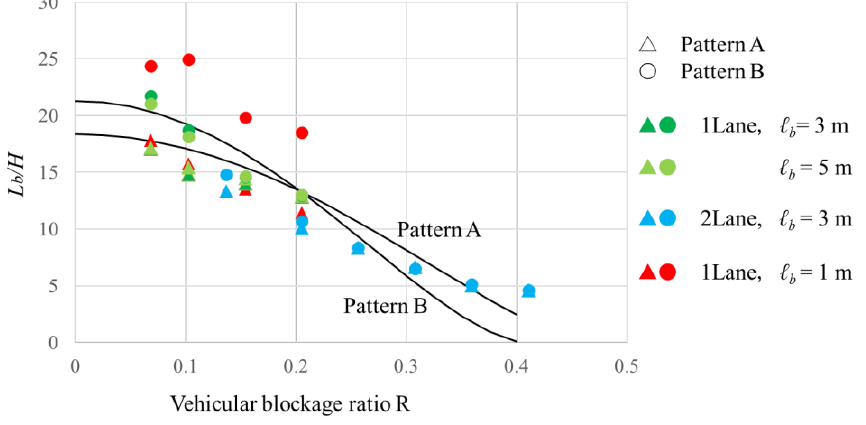
Figure 20. The effect of the vehicular blockage ratio on L b / H in the case of Pattern A and Pattern B. In order to investigate the reason for this, Figure 21 shows the distribution of the x - direction velocity − u / U m when the blockage ratio was 0.2 and ℓ b was 1 m and 3 m. The upper figure shows the horizontal plane of z = 0.5 m, and the lower figure shows the longitudinal section of y = − 0.5 m, penetrating through the center sections of the fire source and the obstacle. Regarding the longitudinal velocity from right to left, in the lane without the obstacle, the longitudinal velocity was 1.5 – 2 times the average longitudinal velocity U m , but the front of the obstacle (left side) was the contraflow domain of the mainstream, within 1 m from the front of obstacle. If ℓ b = 3 m, the longitudinal velocity in the fire source area was 0.8 – 1 times the average longitudinal velocity. However, if ℓ b = 1 m, the fire plume was pulled to the obstacle through this reflux area, and the backlayering length was increased, creating instability.